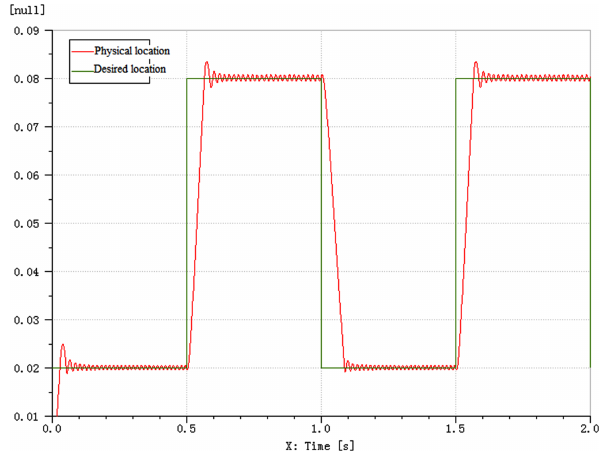
Figure 9. Curves of step response